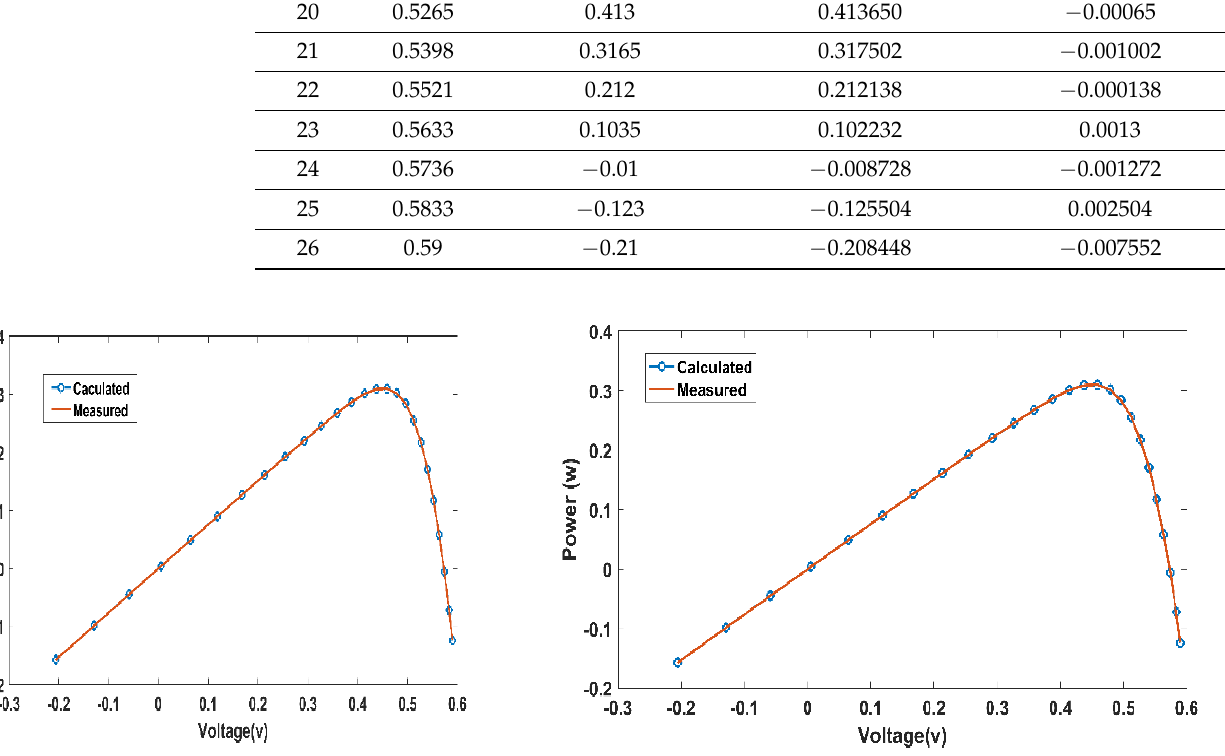
( b ) Figure 9. Measured current vs. calculated by CEHO. ( a ) single diode. ( b ) double diode. The previous results were for the PV panels at standard temperature and radiation. The four EHO algorithms were tested against three other algorithms at different irradi- ance levels and temperatures for more testing. Table 7 shows the extracted parameters for the seven algorithms at different irradiance levels and temperatures. Finally, the three- diode model is tested against three algorithms from [43] (Moth-Flame Optimizer (MFO), FPA, and Hybrid Evolutionary algorithm (DEIM)). The RMSEs for each algorithm at var- ying irradiance levels are listed in Table 8. Again, at low radiation with 109.2 W/m 2 , CEHO outperforms EHO with a slightly small difference but a big difference compared to other algorithms. CEHO outperformed other algorithms at other radiations, and BIEHO ’ s re- sults were slightly different from CEHO ’ s. The superiority of the CEHO algorithm is proven as the best compared with the other three variants and the other three algorithms for all irradiance levels. Figure 10 shows that calculated data fit the I-V curve of measured data for CEHO. Table 6. The relative error for 26 measurements (double diode) with CEHO. No.